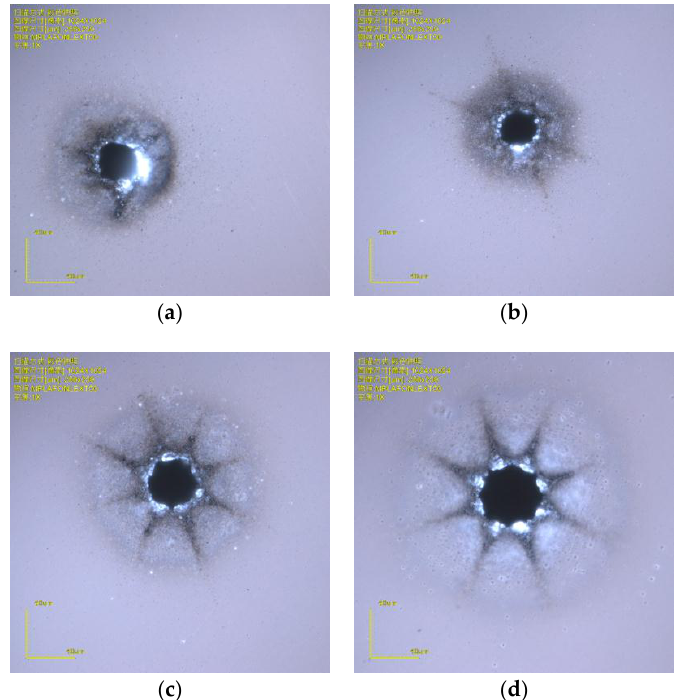
Figure 1. Via holes with different laser path diameters ( a ) 40-μm path diameter with 37.9-μm exit; ( b ) 50-μm path diameter with 49.6-μm exit; (c ) 60-μm path diameter with 58.1-μm exit; and ( d ) 70-μm diameter with 67.7-μm exit.